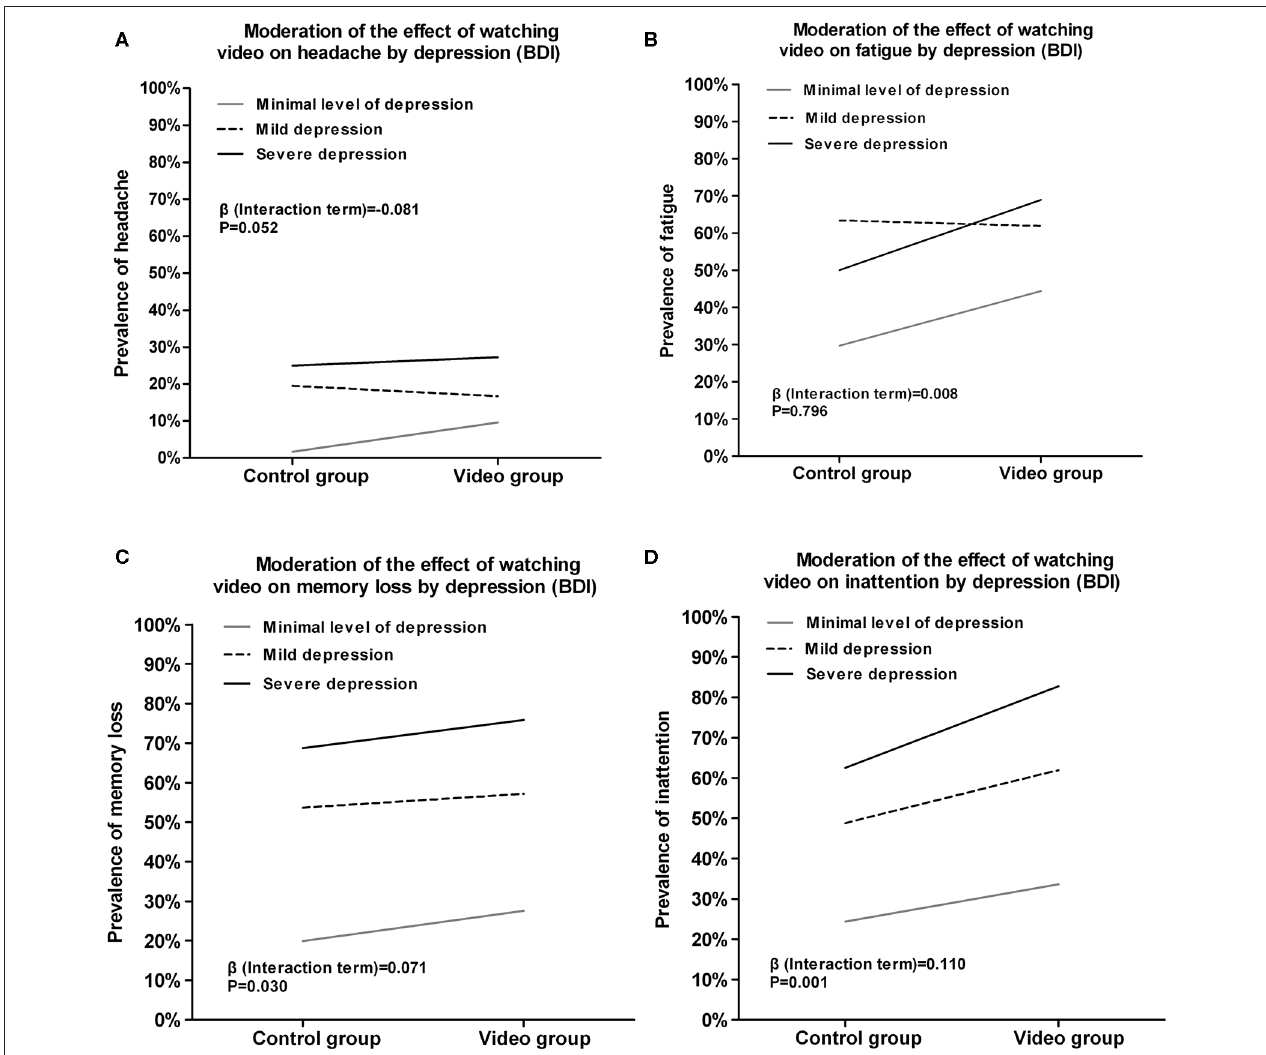
FIGURE 3 | Moderation of the effect of watching video on self-reported symptoms by depression (BDI). (A) Moderation of the effect of watching video on headache by depression. (B) Moderation of the effect of watching video on fatigue by depression. (C) Moderation of the effect of watching video on memory loss by depression. (D) Moderation of the effect of watching video on inattention by